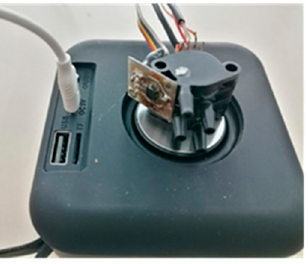
Figure 7. Electrodynamic exciter for testing the in fl uence of dynamic acceleration.